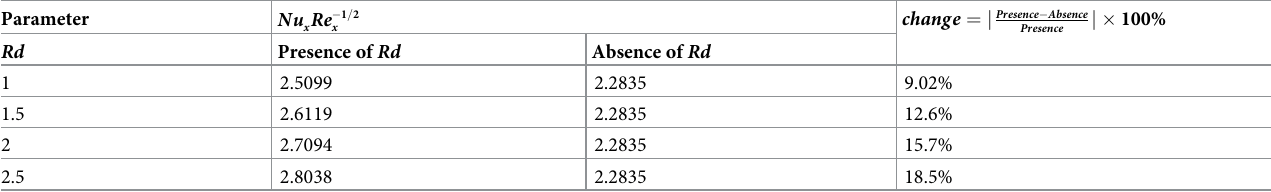
Table 4. Heat transfer analysis in the presence/absence of thermal radiation.